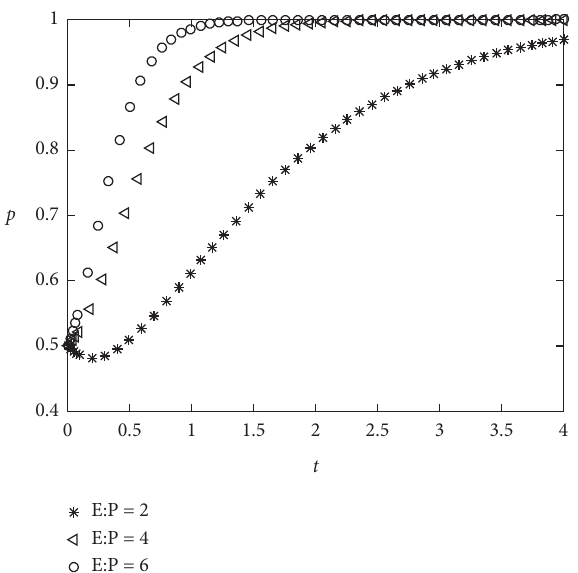
Figure 5: The impact of punishment on the enterprises’ Figure 6. In this experiment, H is set as 1, 2, and 3, re-